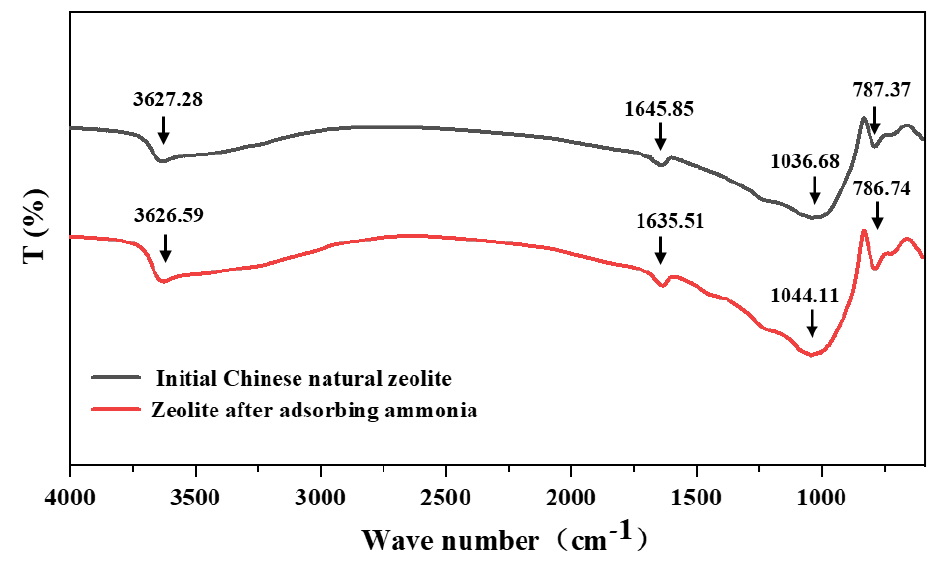
Figure 6. FTIR spectra of the Chinese natural zeolite before and after adsorption of high-concentrtion ammonia.